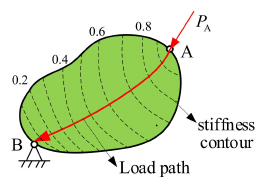
Figure 5. The main load path for a sample